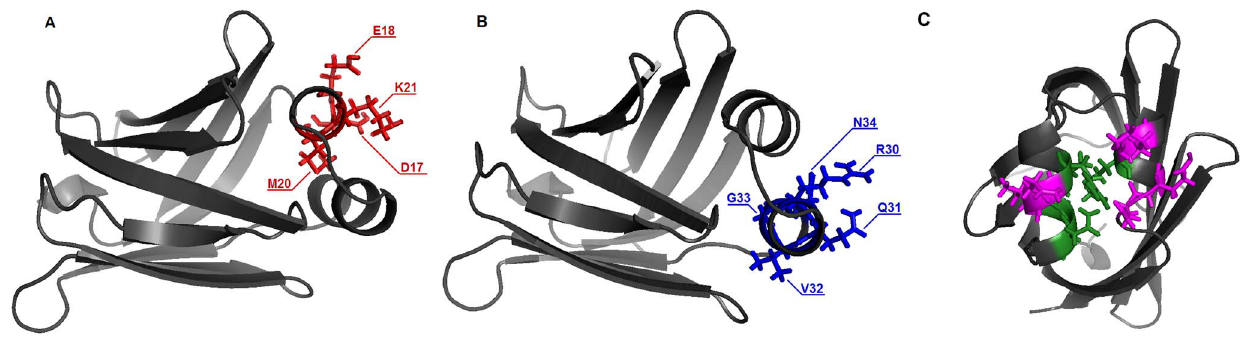
Figure 1. Top view of the three-dimensional structure of human B-FABP (PDB ID 1JJX), showing the native residues that were mutated to Cys residues in a -helix A1 (A) or in a -helix A2 (B). Panel (C): front view of the three-dimensional structure of human B-FABP (PDB ID 1JJX), showing the residues that form the group I (magenta), and the residues which form group II (green) discussed in the text.